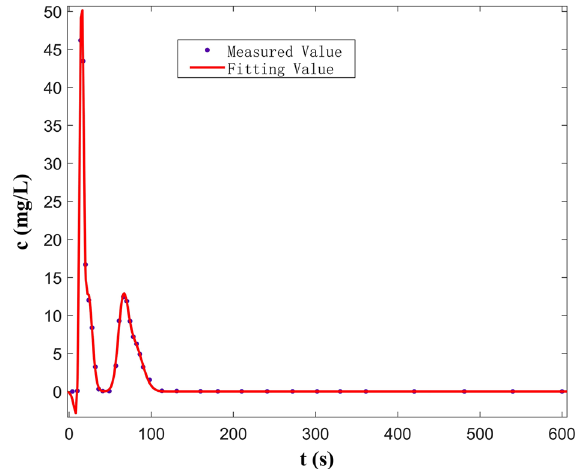
Figure 15. Curve fitted by Gauss multi-peaks method (C 2 -D 2 ).